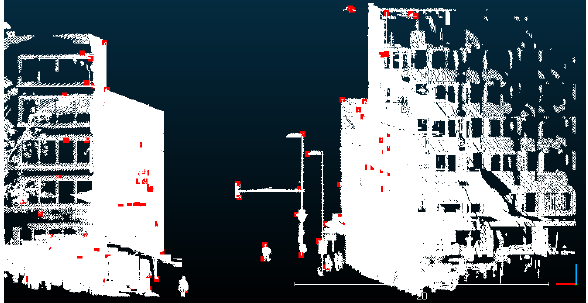
Figure 7. The extracted feature points, shown in the 3D point